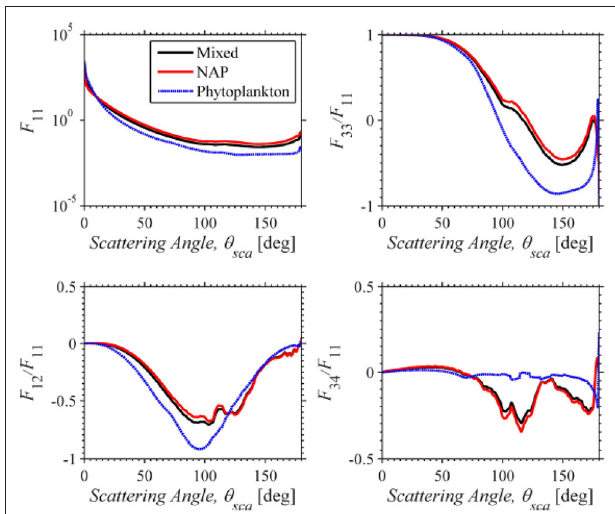
FIGURE 5 | Scattering phase function and normalized polarization elements of the scattering matrix from Mie calculations for one case as an illustration for n nap 1.18, n ph 1.06, ξ nap 4.0, ξ ph 4.0, [NAP] 1.45g m − 3 , and = = = = = [Chl] 10.5mg m − 3 at 440nm. Reuse with permission from Ibrahim et al. =